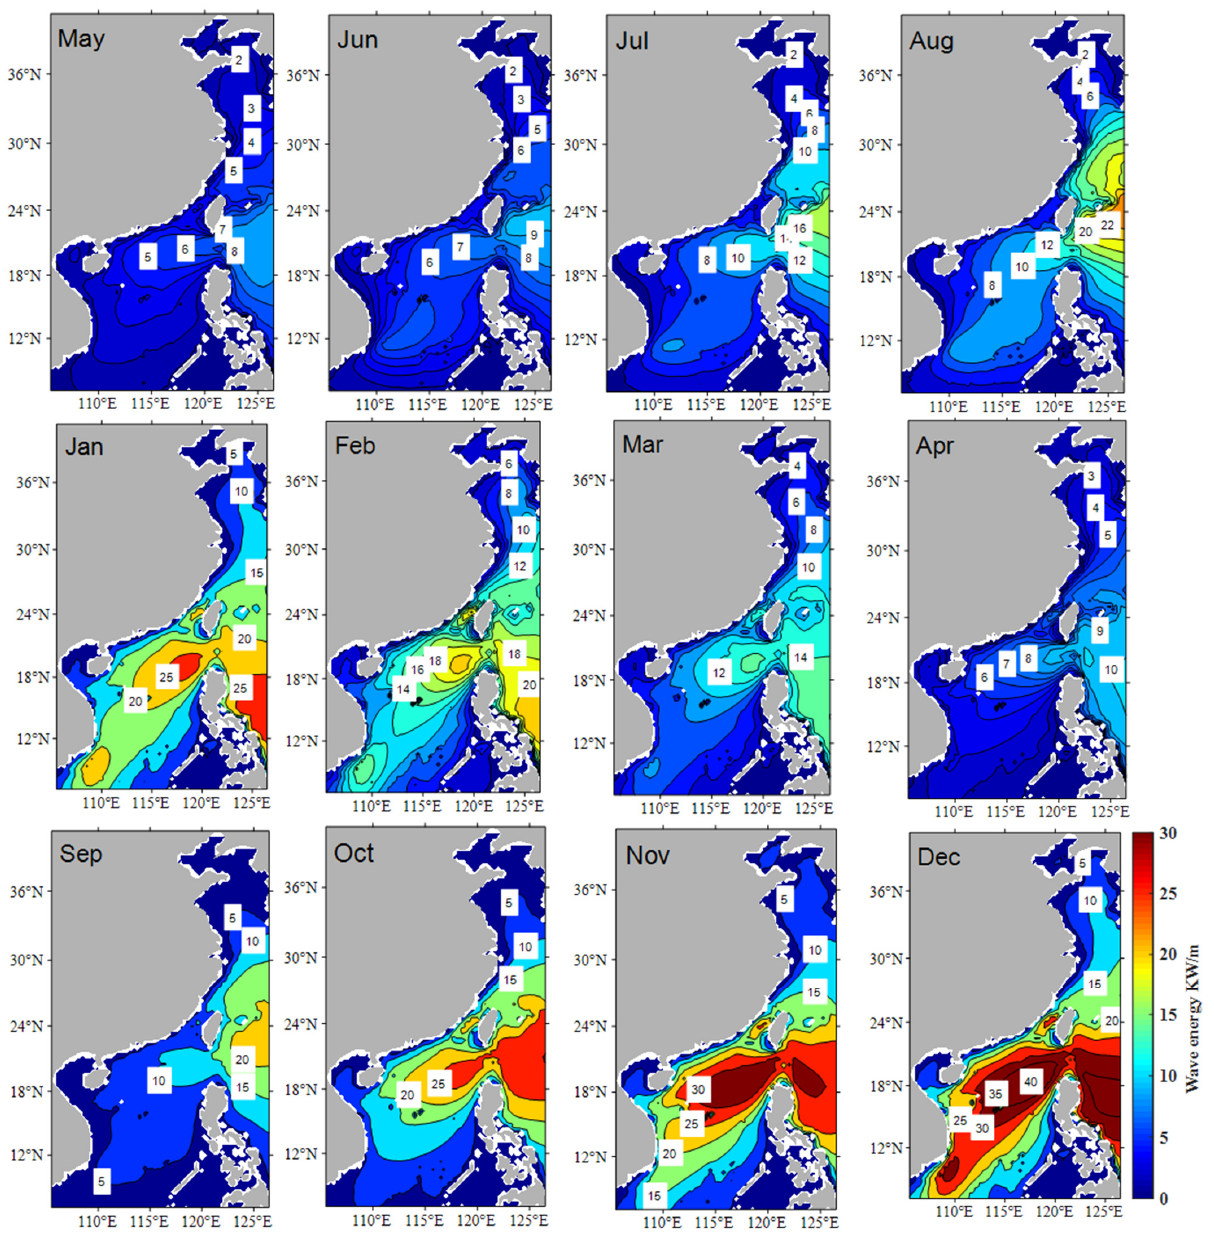
Figure 4. Monthly mean P w.